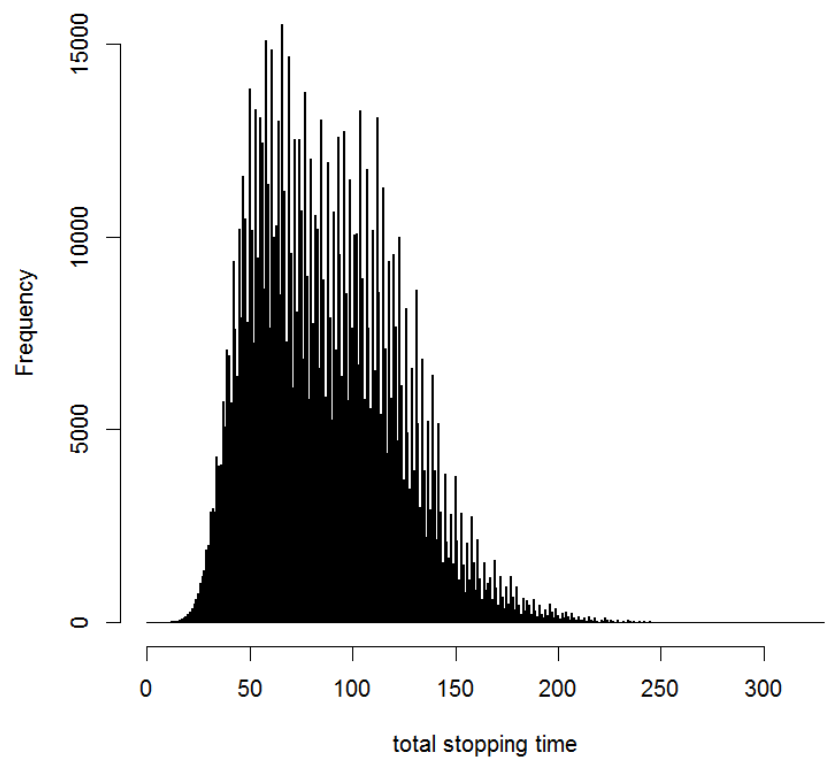
Figure 2. “Structureless” distribution of the total stopping time for the first 1 × 10 6 natural